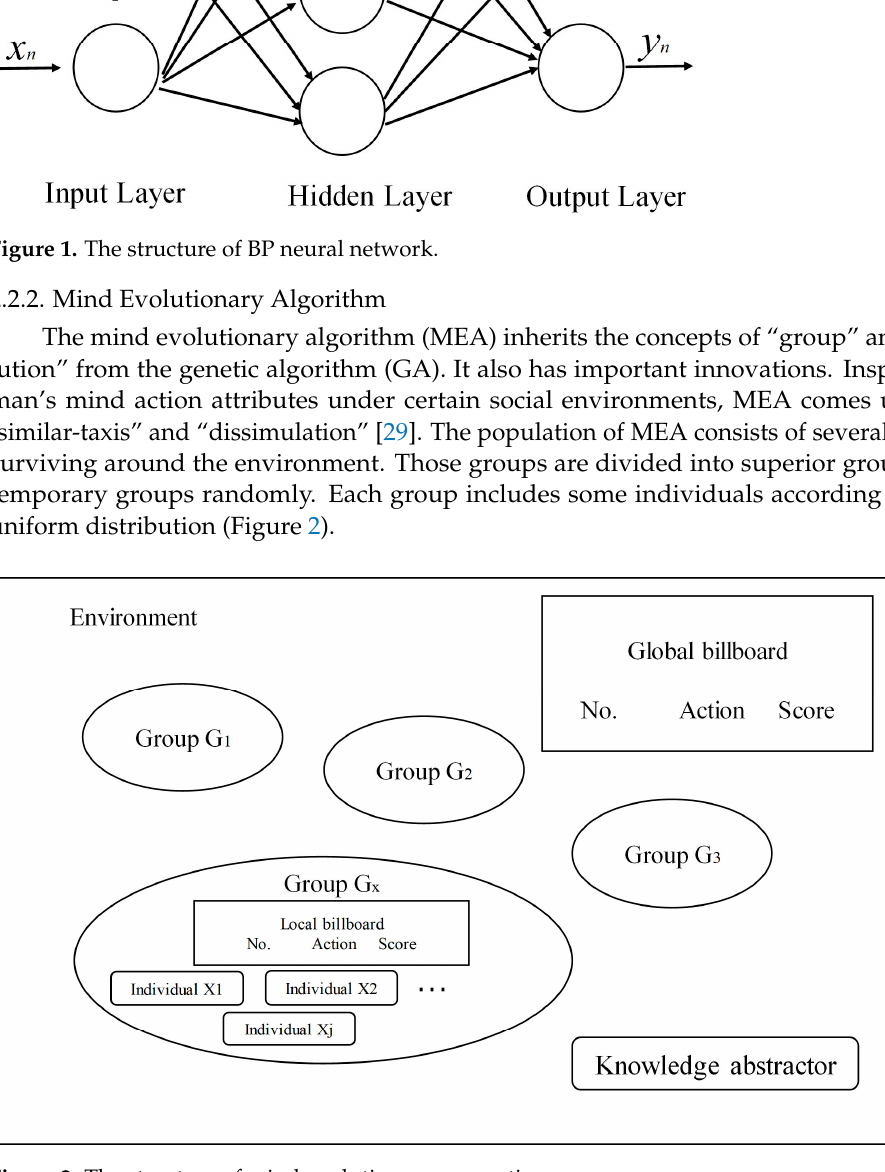
Figure 1. The structure of BP neural network.